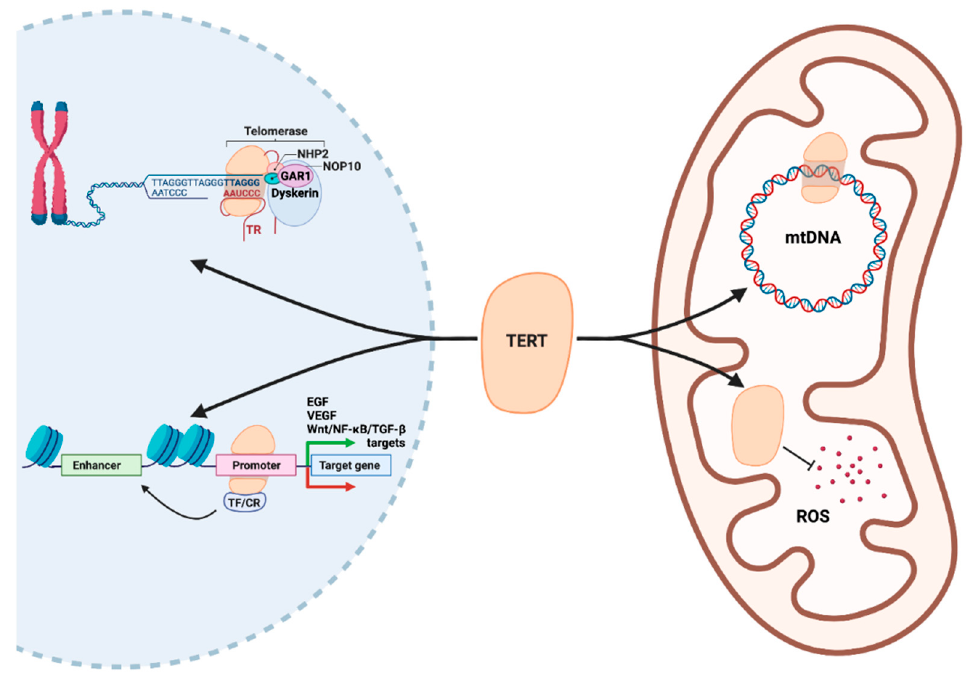
Figure 3. Extratelomeric functions of TERT. In the nucleus (left), TERT carries out its canonical role in telomere extension in complex with the other components of the telomerase holoenzyme (TR, dyskerin, GAR1, NOP10, NHP2). In addition, TERT binds to the promoters of genes that encode key growth factors (EGF, VEGF), as well as secondary effectors of tumor-promoting signaling pathways (Wnt, NF- κ B, TGF- β ), thereby positively or negatively regulating their expression. These transcriptional effects are frequently mediated by the actions of TFs or chromatin remodelers (CR) that complex with TERT at its target loci and influence both local and distant chromatin structure (i.e., at enhancers). In mitochondria (right), TERT possesses transcriptional, metabolic, and detoxification functions. In particular, TERT recognizes specific sites in the mitochondrial genome (mtDNA), which both alters mitochondrial gene expression and shields mtDNA from damage. Additionally, TERT plays a DNA-independent role in the neutralization of reactive oxygen species (ROS), which otherwise induces DNA damage and institute a host of aberrations in cellular metabolism and survival.